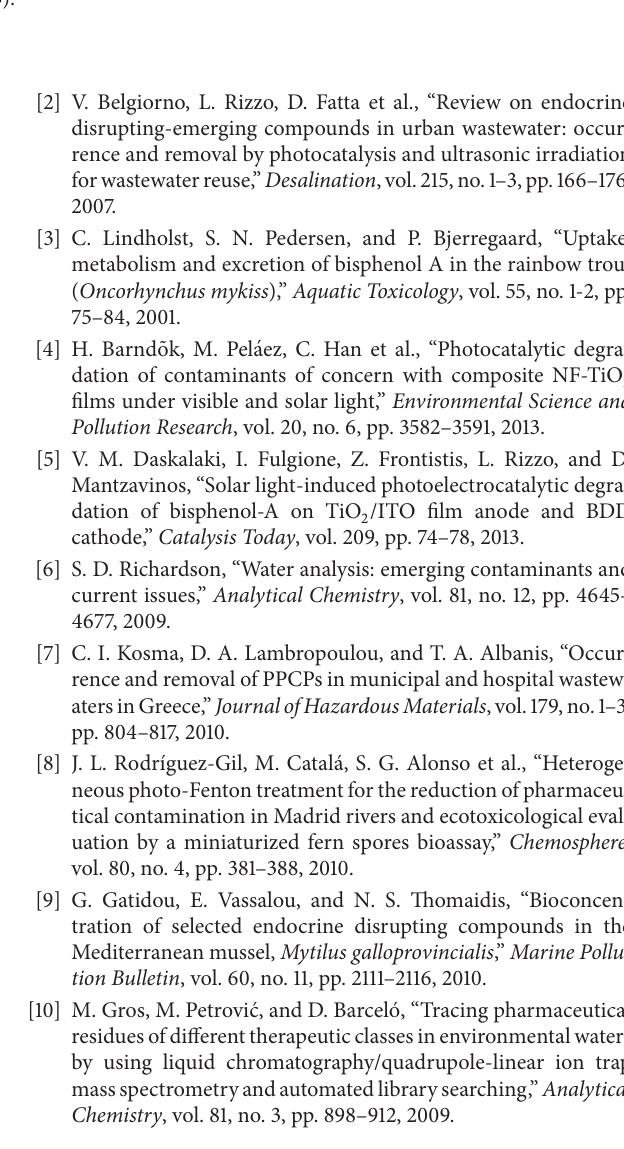
Figure 11: Degradation of a mixture of BPA and EE2 in WW at 1.6 mg/cm 2 ZnO. Effect of (a) 100 𝜇 g/L EE2 on 50, 100, and 200 𝜇 g/L BPA and (b) 50, 100 and 200 𝜇 g/L BPA on 100 𝜇 g/L EE2. Inset graph: plot of (3).